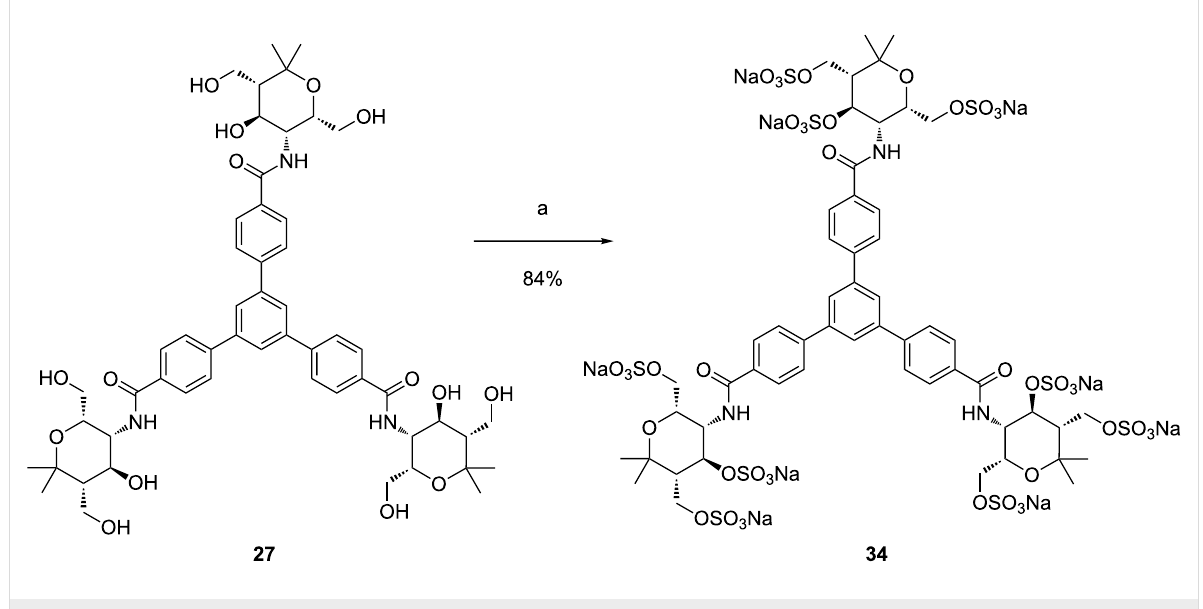
Scheme 7: Conversion of trivalent compound 27 into nonasulfated carbohydrate mimetic 34 . Conditions: a) 1) SO 3 ∙ DMF, DMF- d 7 , 3 d, rt; 2) 0.5 M NaOH, 0 °C, DOWEX ® Na + ; 3) dialysis, H 2